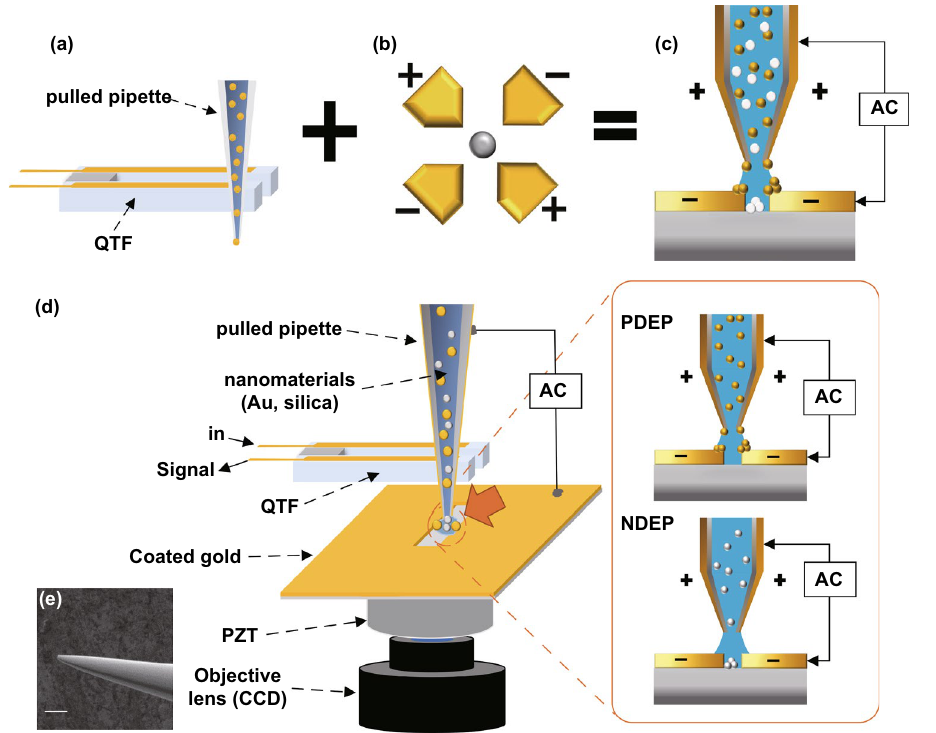
Fig. 1 Schematic diagram of the experiment. a QTF-AFM with a pulled pipette system. It has strength in efficient low-volume liquid delivery. b Quadrupole DEP trap. If the Clausius–Mossotti factor is below zero, solutes receive a negative-DEP force and go to the center of the electrodes. c We propose the DEP-based material-selective deposition technique using the pipette-AFM system. The pipette-AFM delivers the low-volume solution to the desired position and DEP forces deposited nanoparticles on the edge or middle position of electrodes. Yellow particles show the positive-DEP effect and white particles show the negative-DEP effect. d Detailed schematic diagram of the experimental setup. XY positioning of the pipette on the scratched gap is enacted while watching the optical microscope image of CCD in real-time, and the Z positioning (approach and retract) of the pipette is enacted under QTF-AFM feedback. An AC voltage is applied between the coated Au layer on the glass substrate and the surfaces of the Au-coated pulled pipette. e Detailed SEM image of the coated pulled pipette, 10 µm scale